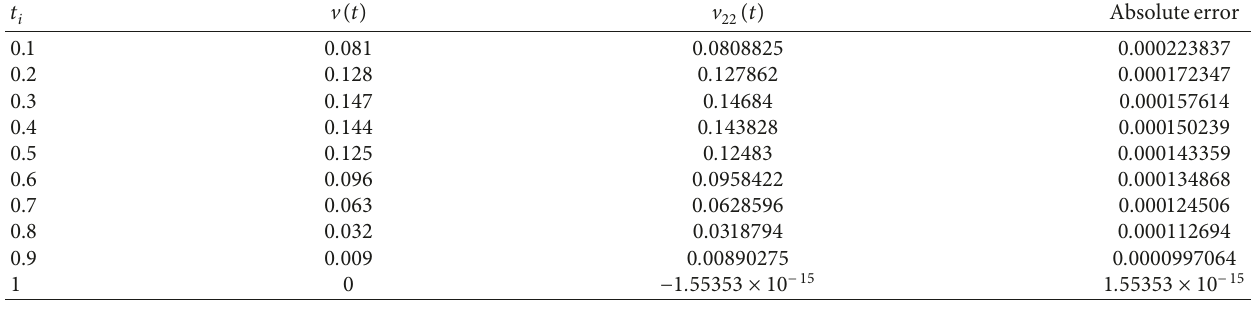
Table 1: The absolute error for Example 1 with n � 22.